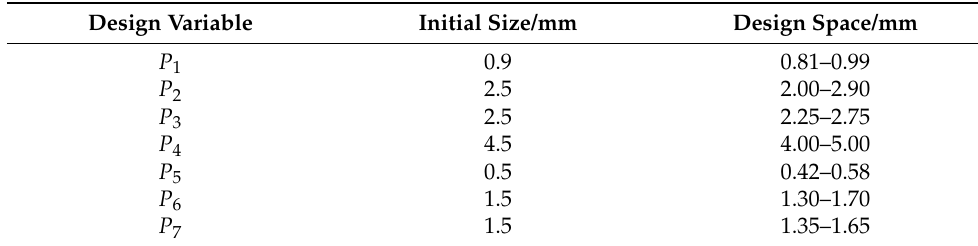
Figure 5. Parametric structure of the HUM stator. Table 2. Initial size and design space of the HUM stator.